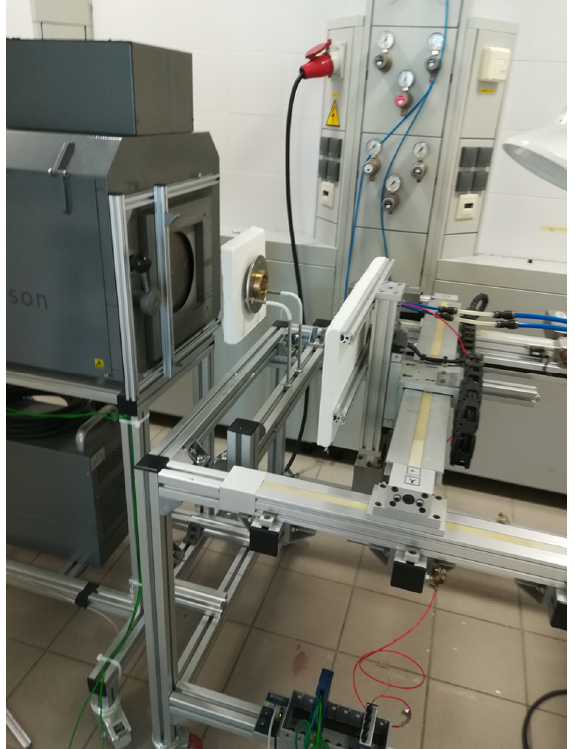
Figure 4. General layout of the solar radiation simulator/projector by xenon arc lamp, and the XYZ coordinate table.